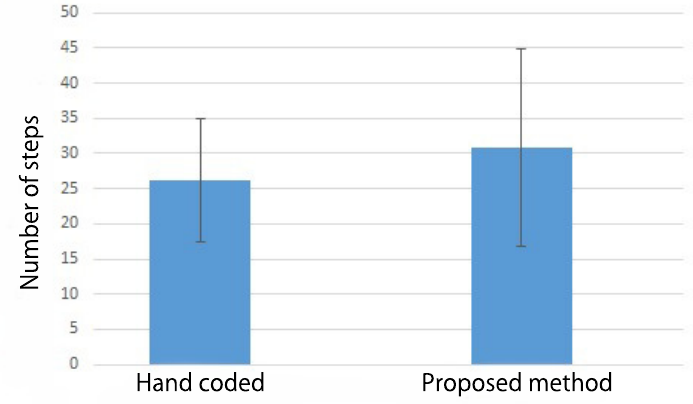
Figure 13. Averaged number of steps and standard deviation over five trials ( n = 5) in Robot 2, for comparison between the proposed and hand-coded